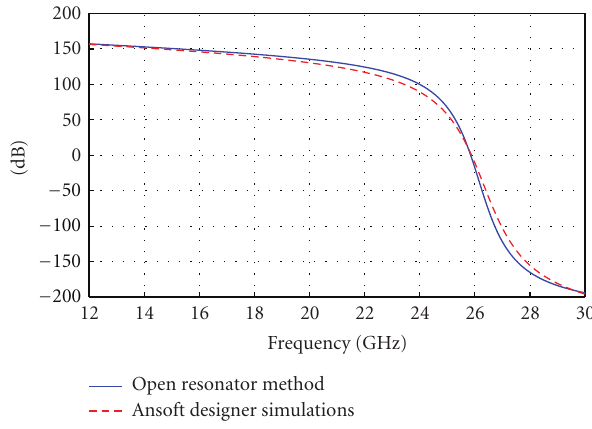
Figure 12: Reflection phase versus frequency for the case L = 3 . 2mm.